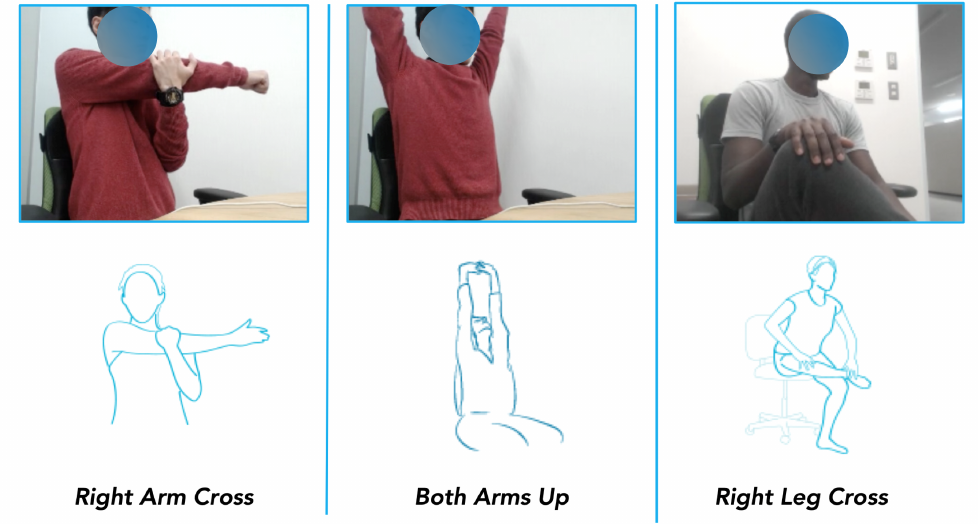
Figure 5. Examples of stretches preformed by experiment participants. Right Arm Cross, Both Arms Up, and Right Leg